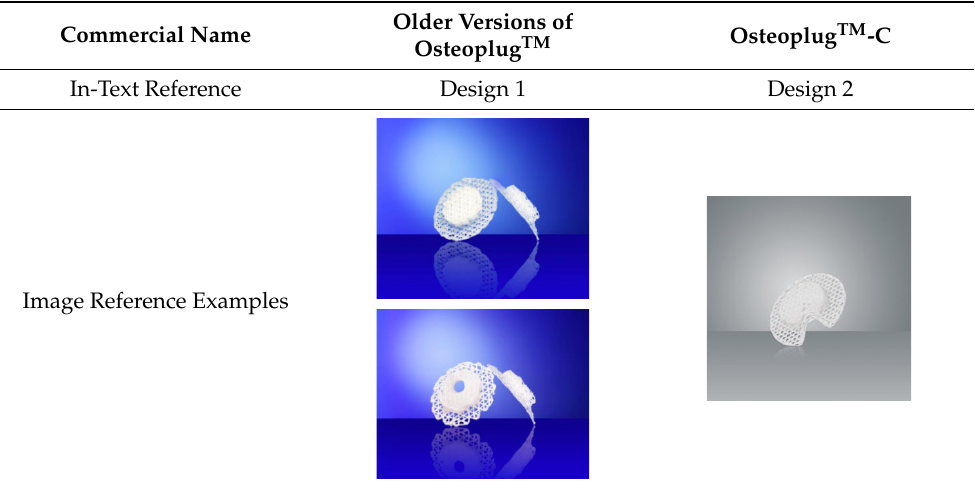
Table 1. Latest designs of Osteoplug TM and in-text references.